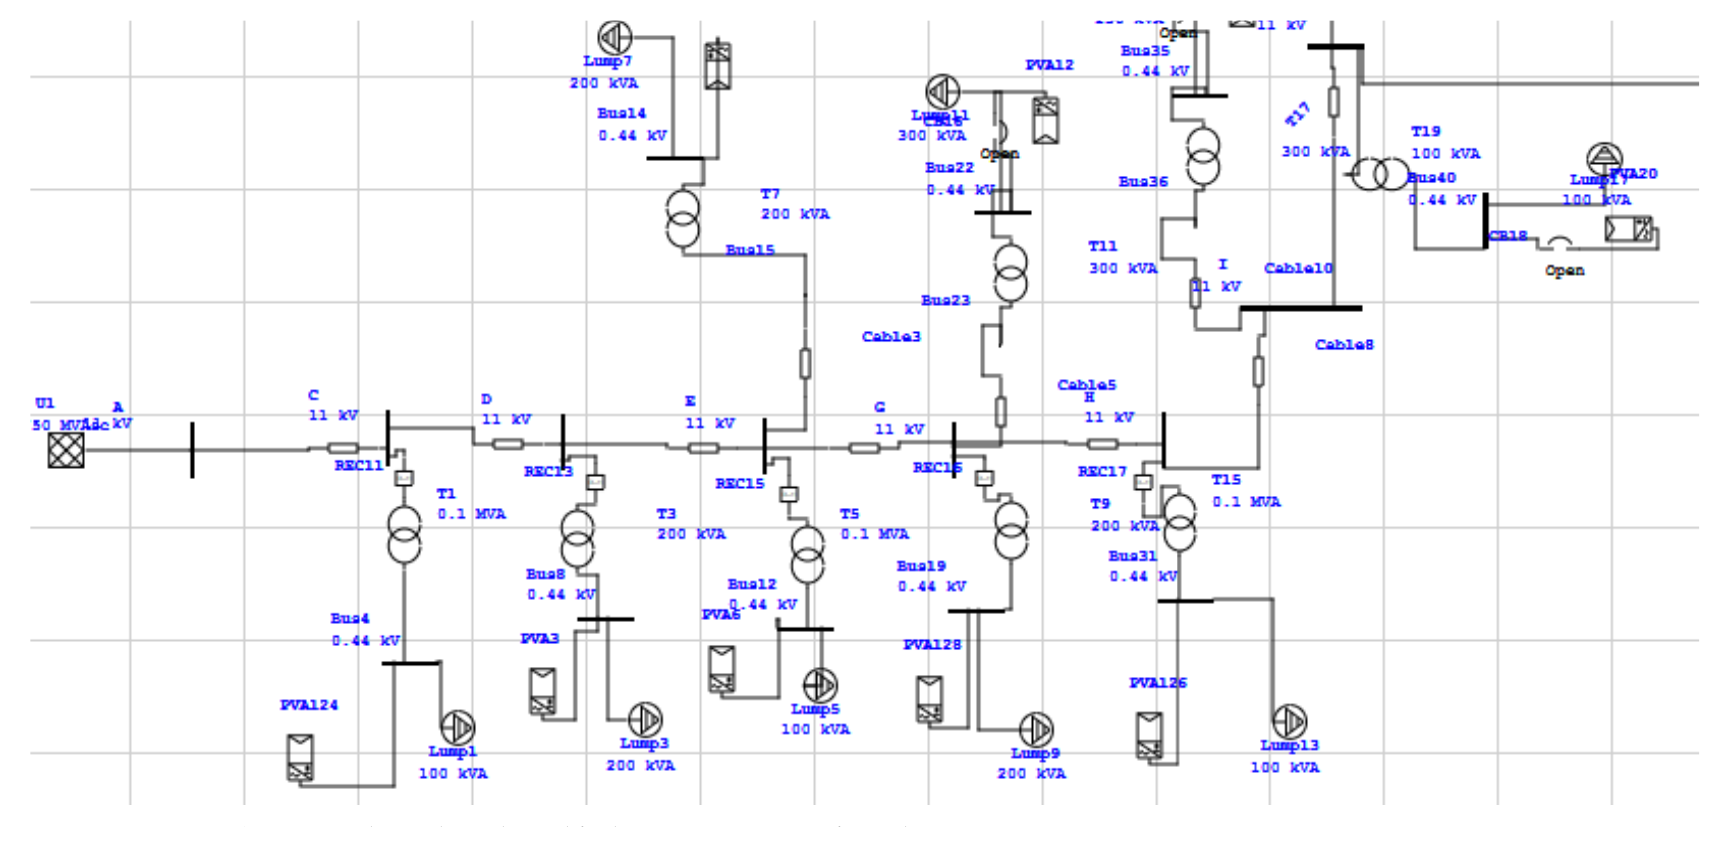
Figure A1. 90 bus 11 kV Industrial feeder in ETAP (Portion of Punjab Power System).